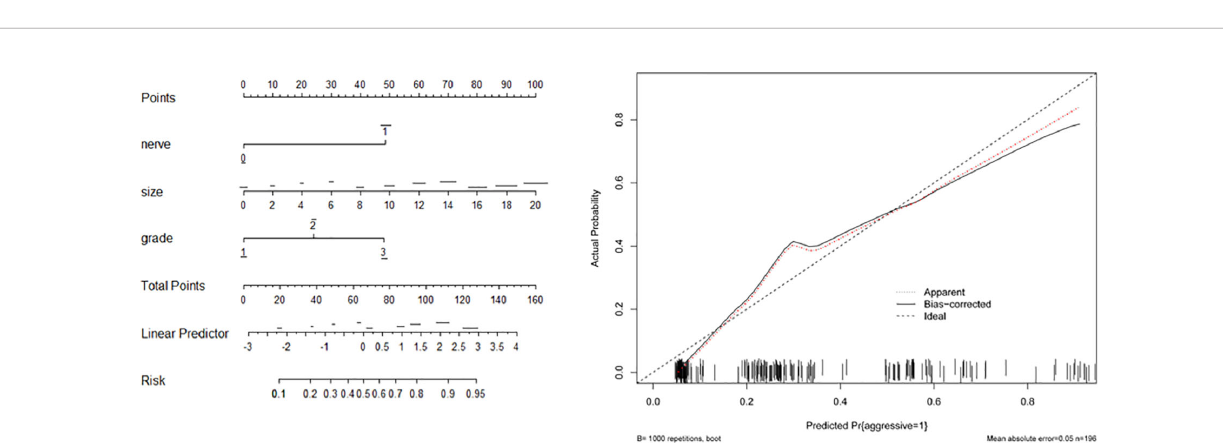
FIGURE 2 | Nomogram (left) and calibration curve (right) of aggressive behavior of pancreatic neuroendocrine tumors (PNET) in G1/G2 patients. Neural invasion (nerve), tumor size and tumor grade were included in the gram.